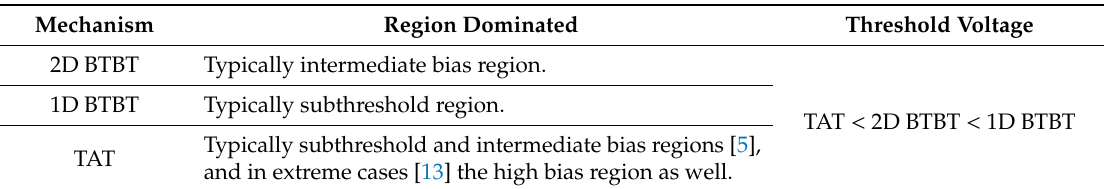
Table 1. Current mechanisms in line tunneling TFETs and their threshold voltages.